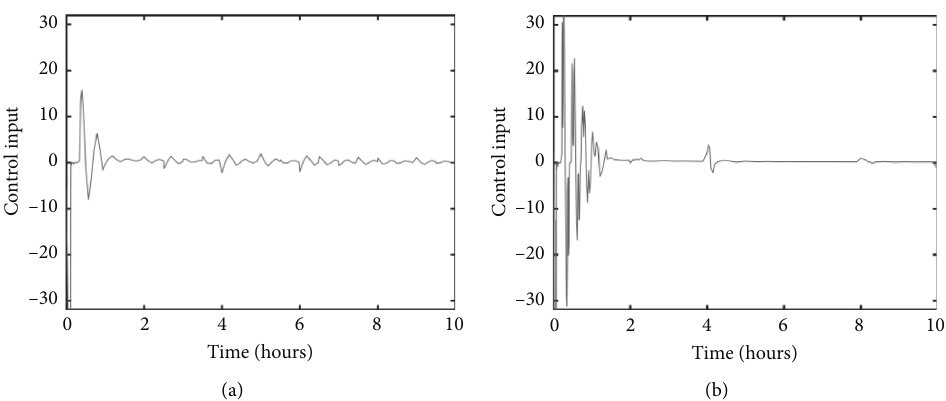
Figure 4: The control input of (a) integral sliding mode control and (b) fuzzy integral sliding mode control.